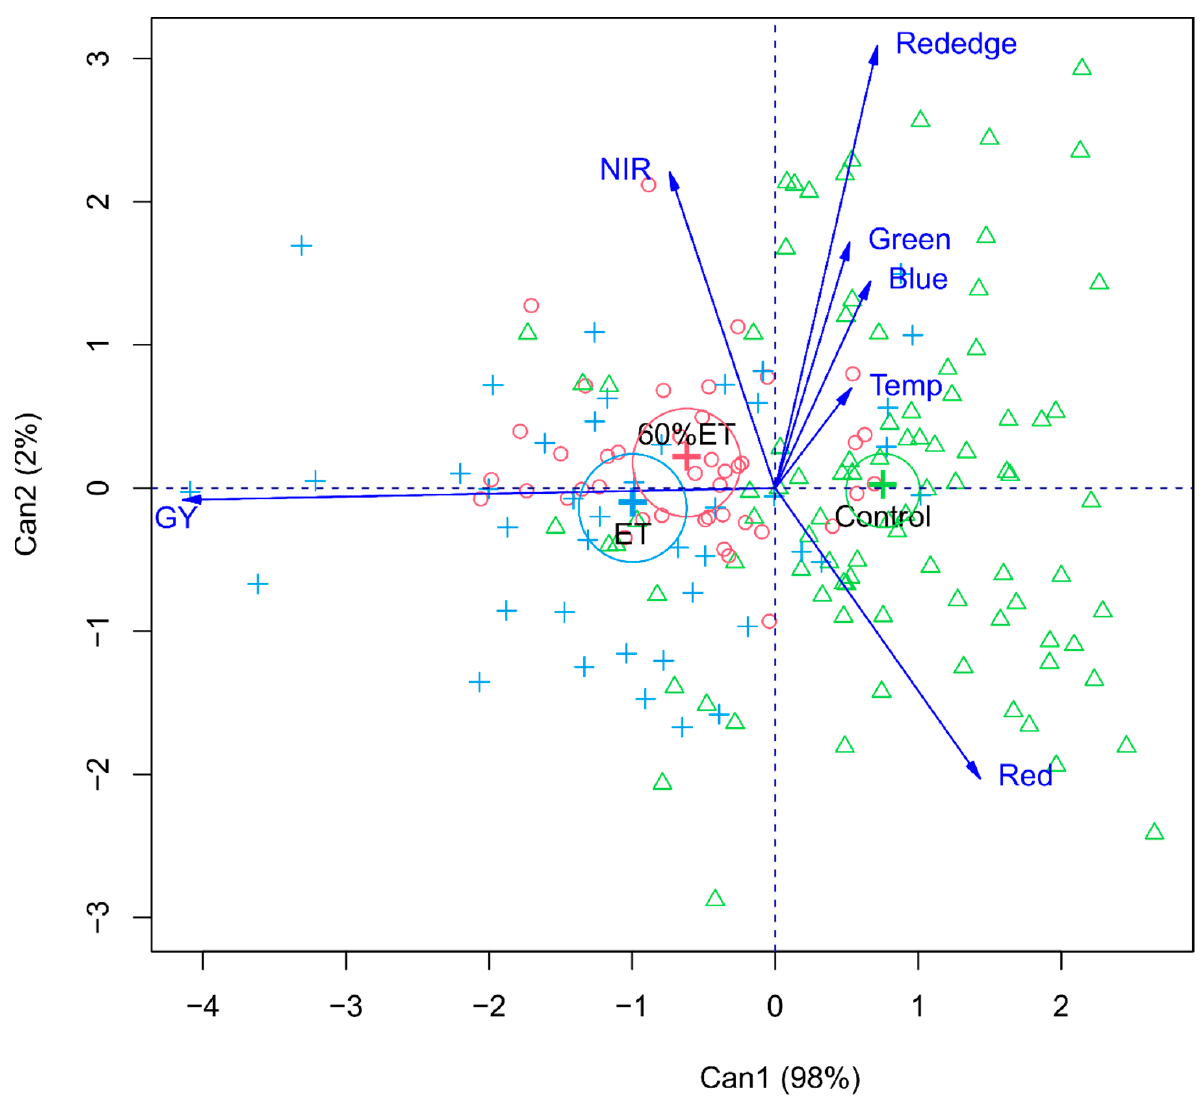
Figure 3. Canonical variable analysis for the evaluation of spectral variables (Red, Green, Blue, NIR, red ‐ edge, NDVI, NDRE, SAVI, EVI, GLI), grain yield (GY), and leaf temperature (Temp) with the irrigation managements [control, 60% of the crop evapotranspiration (ET) and 100% of ET]. Table 3. Summary of analysis of variance for Pearson correlation coefficients (r) and mean absolute error (MAE) by different inputs and Machine Learning (ML) models